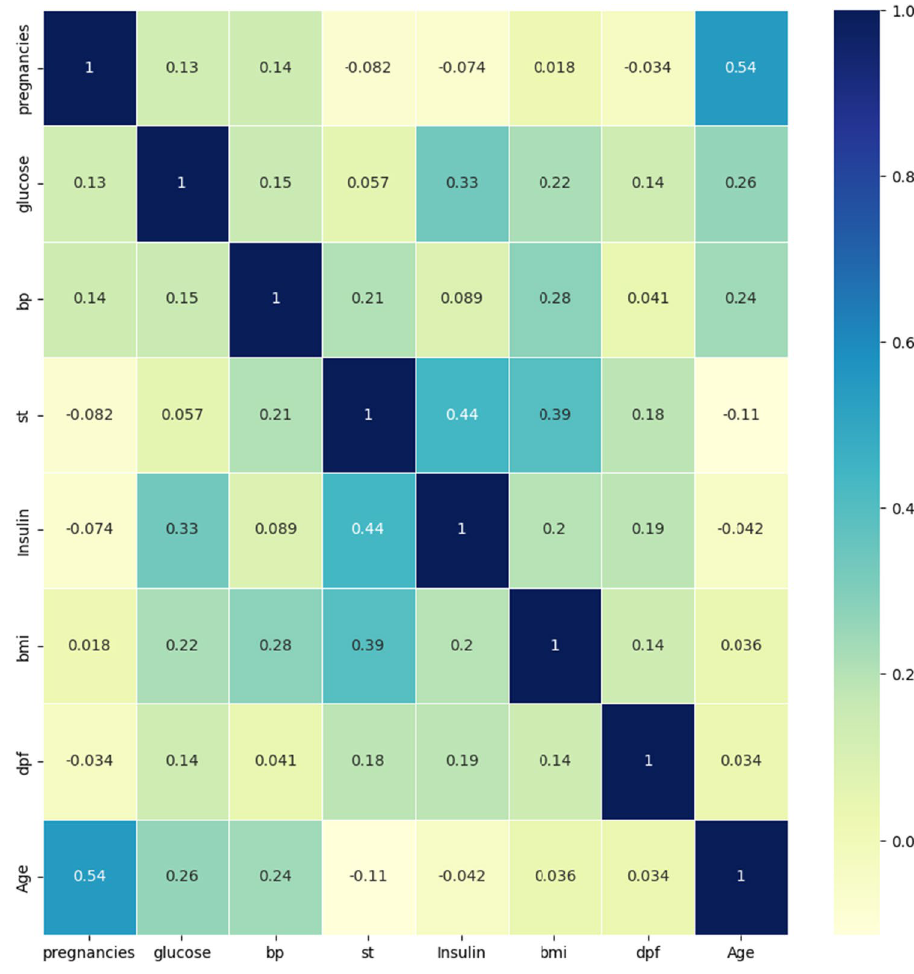
Fig. 2 Feature correlation of PIMA dataset